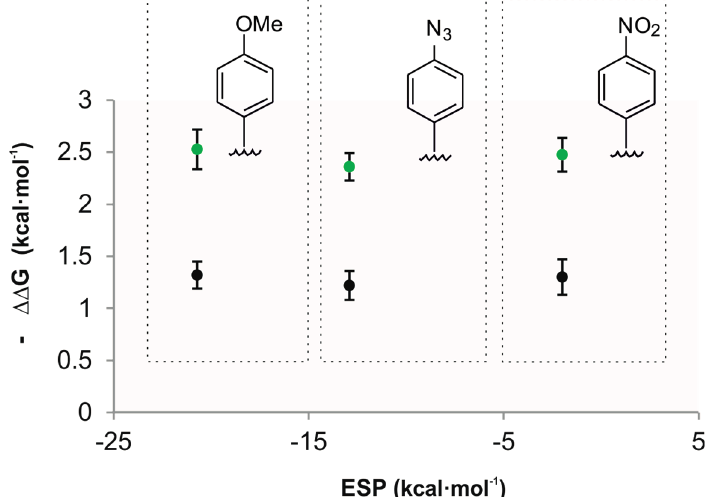
Figure 5. Plot of the experimental free energy values calculated for the CH- π interactions of guests 2a ( black ) and 2b ( green ) vs. the ESP values calculated in vacuum at the centroid of the aromatic rings using a model system based on “two-wall” calix[4]pyrrole